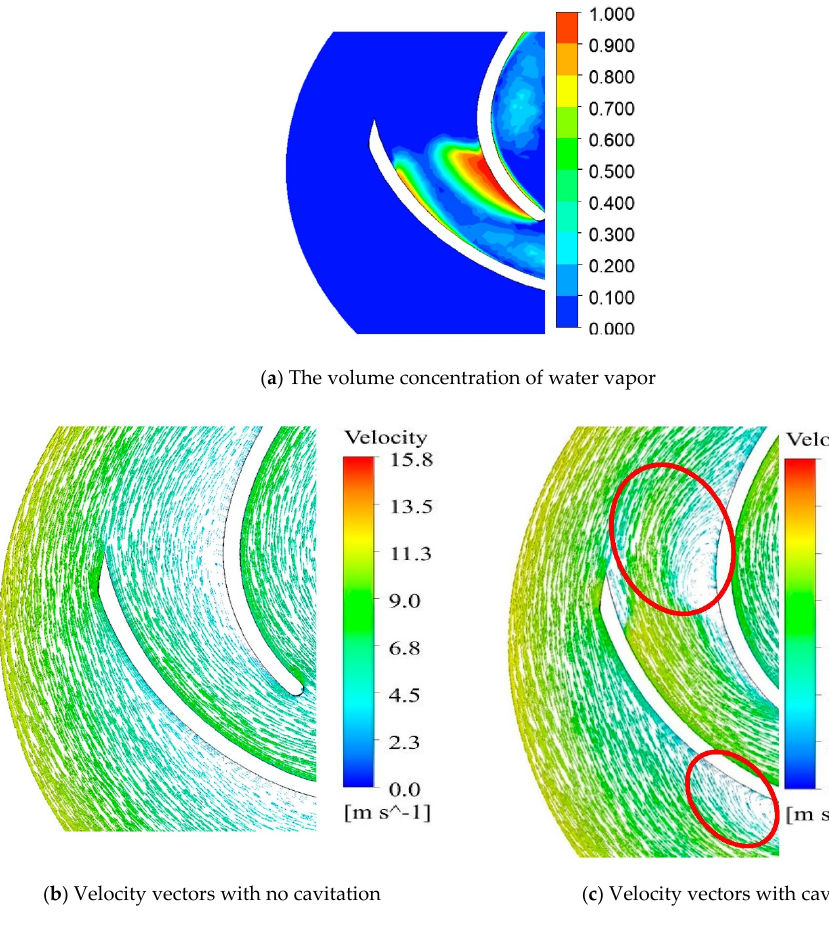
Figure 21. ( a ) Volume concentration of water vapor contours in the blade passage ( b ) Velocity vectors in the blade channels with no cavitation, ( c ) Velocity vectors in the blade channels with cavitation while volume concentration of the particles is 5%.